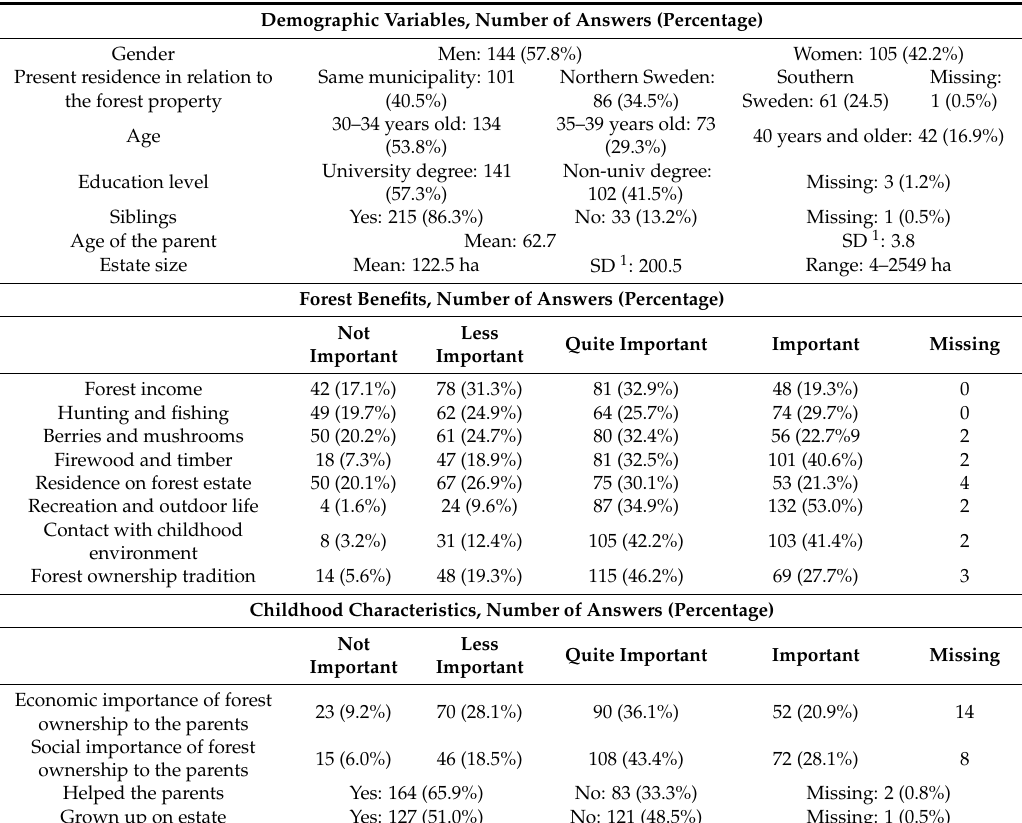
Table 1. Variables used in the binary logistic regression.